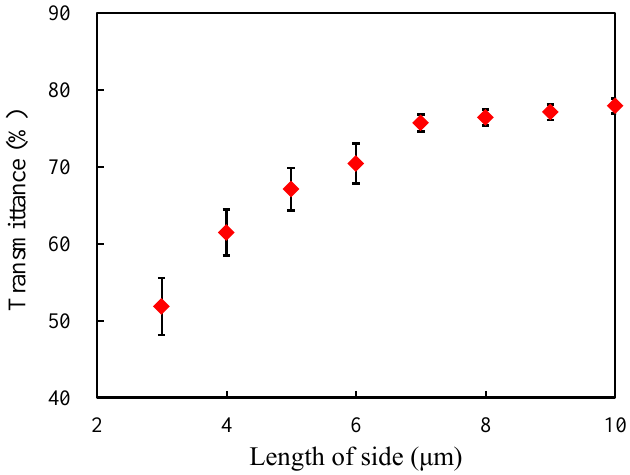
Figure 8. Evolution of the transmittance with the length of